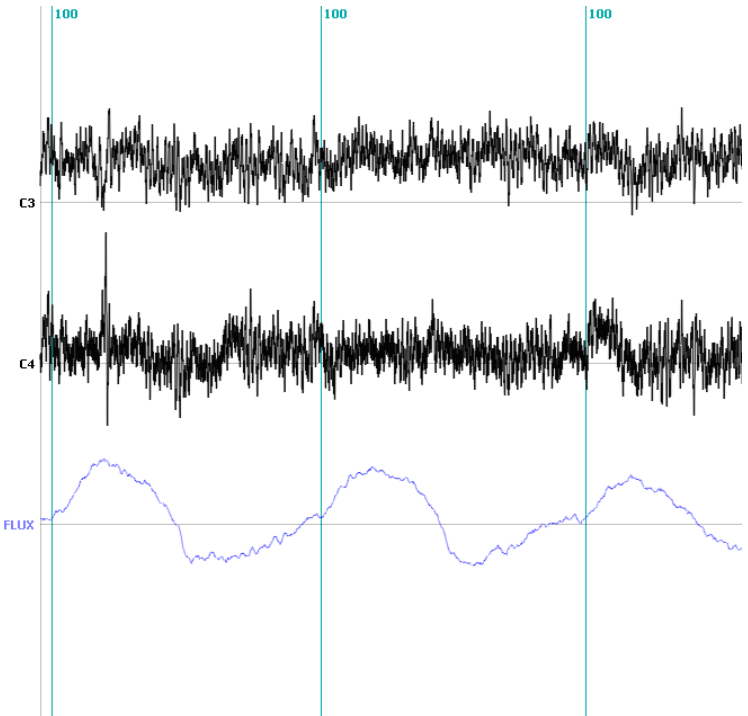
Figure 3. EEG traces measured on C3 and C4 ( black ) during inspiratory and expiratory effort in a healthy volunteer. The lower ( blue ) trace depicts the air flow simultaneously measured by a pneumotachograph. The vertical lines ( marker 100 ) denotes inspiration onset as detected from the flow